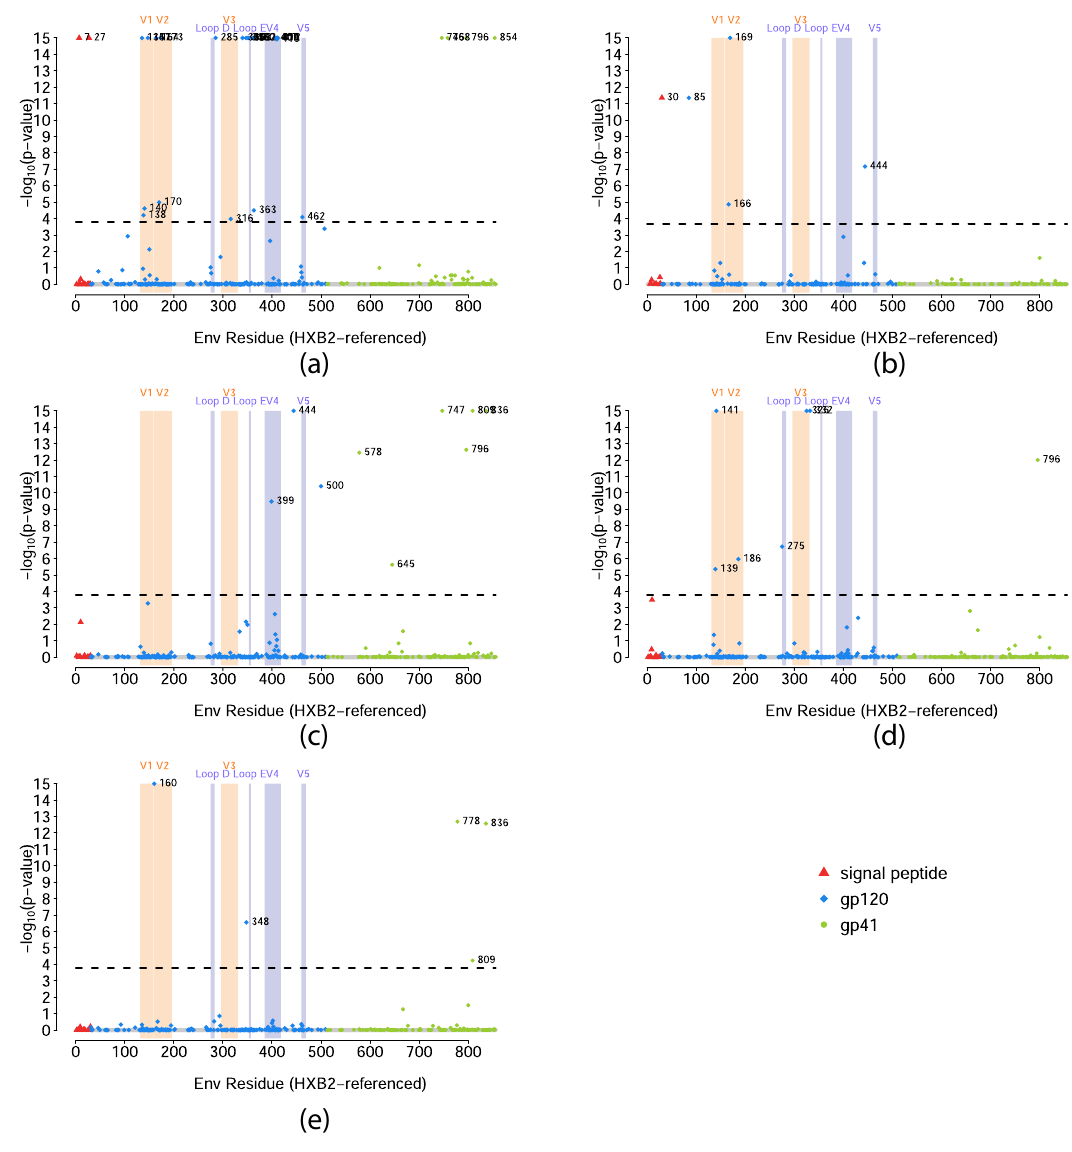
Figure 5: Signi fi cant AA residues for fi ve antibodies. Orange highlights denote V1/V2/V3 loop regions that are putatively associated with these antibodies; purple regions highlight additional functional regions of the gp120 protein. Gray points denote residues that did not pass variability screening. ( a ) VRC01, ( b ) VRC26.08, ( c ) 10 - 1074, ( d ) PGT121 and ( e )